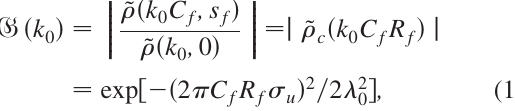
FIG. 5. (Color) Left: initial spatial density in grid coordinates ð x analytical gain factor G ð 2 Þ ð k and blue dots). The numerical gain is calculated as the ratio G ð k as the ratio of the peak values of the Fourier spectra (blue